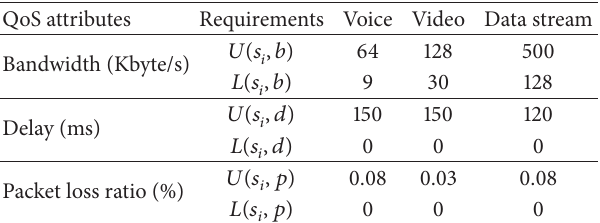
Table 2: Applications settings. Table 3: Model settings.